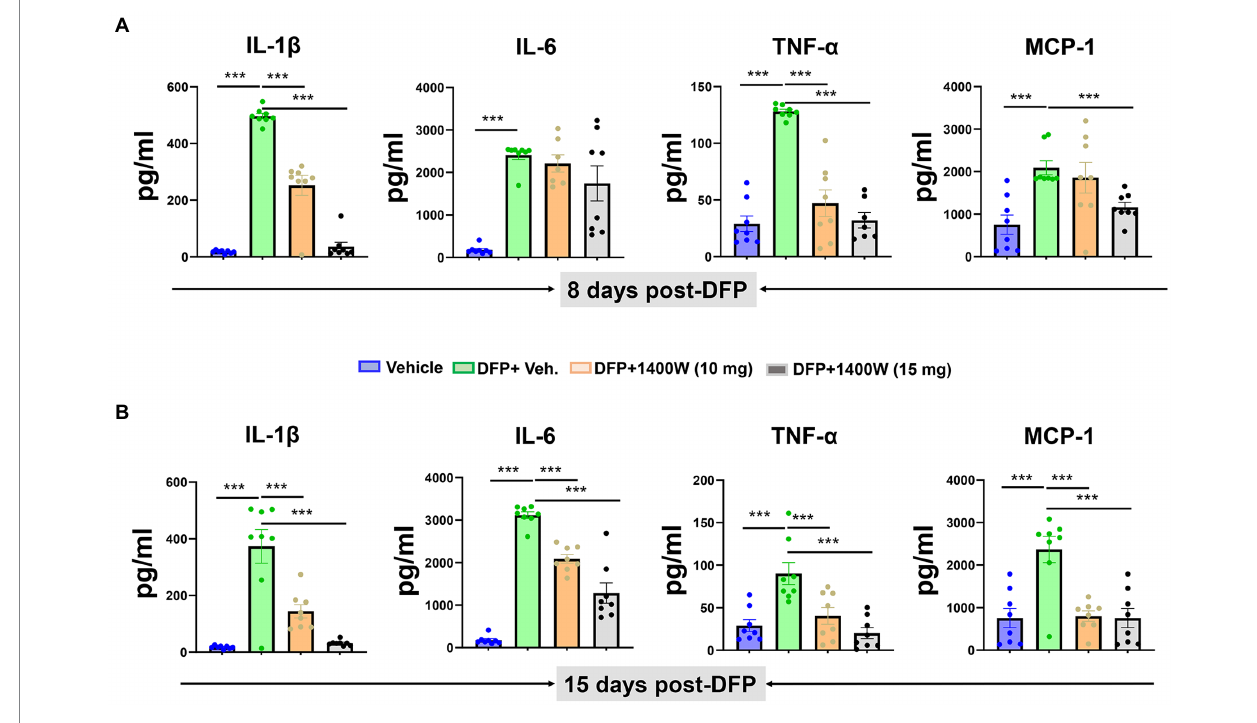
FIGURE 7 The effects of 1400W on the DFP-induced serum pro-inflammatory cytokines. At 8-day post DFP, 1400 W at 10 mg/kg significantly reduced the DFP induced IL-1 β and TNF- α but not MCP-1, while 1400W at 15 mg/kg significantly reduced DFP induced IL-1 β , IL-6, TNF- α and MCP-1 (A) . At 15-day post DFP, 1400 W both at (10 mg/kg and 15 mg/kg) significantly reduced the upregulated cytokine levels following DFP exposure (B) , n = 8, one-way ANOVA with Tukey’s post-hoc for multiple comparisons; * p < 0.05, ** p < 0.01, *** p <